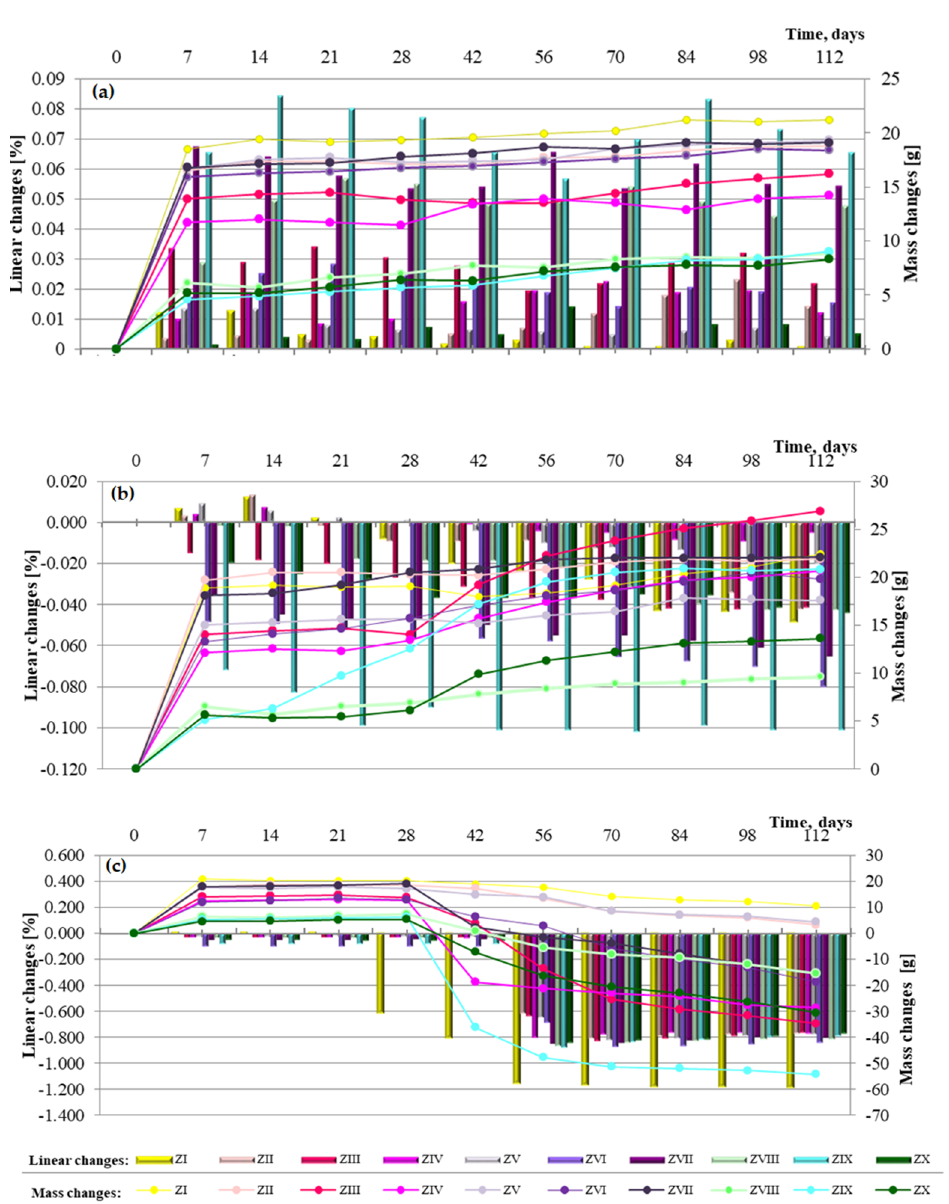
Figure 11. Linear and mass changes of cement mortars containing fluidized bed combustion fly ashes and mixtures of fly ashes from fluidized bed combustion and conventional combustion observed for a period of 112 days in the different environments: ( a ) in water, ( b ) in sea water and ( c ) in the carbonation.